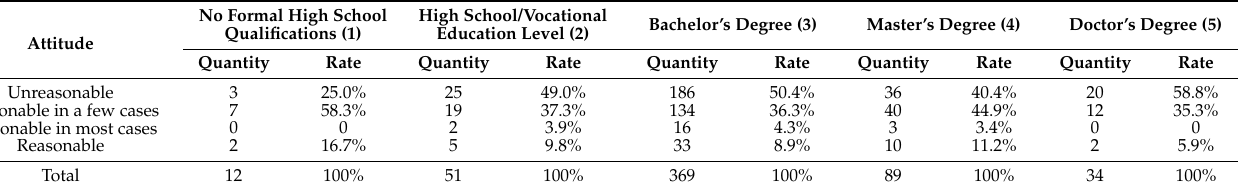
Table 5. Statistical analysis of attitude disparities on GD among different educational levels.